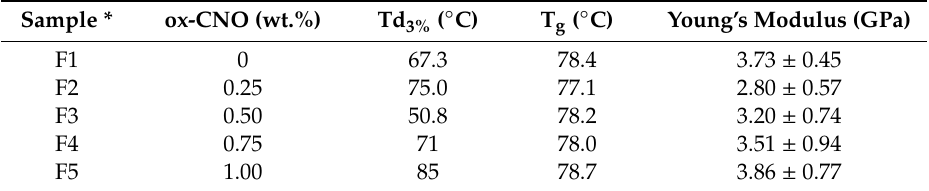
Table 2. Td 3% , Young’s modulus, and glass transition temperature (T g ) of CS / PVA and CS / PVA / GO